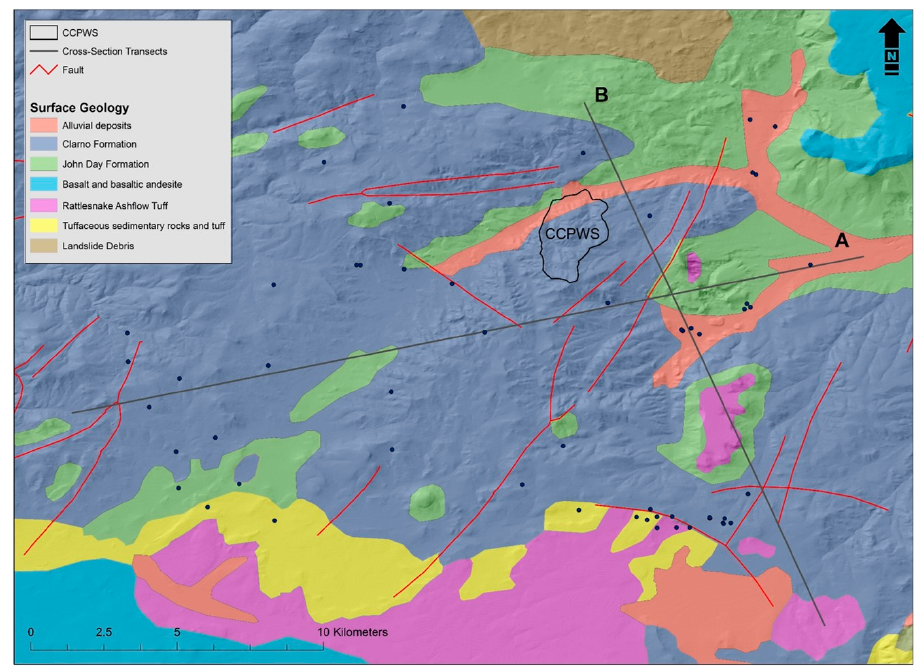
Figure 2. Surface geology map illustrating cross-section locations and main geologic features in both the CCPWS site and the entire hydrogeologic framework area of interest.